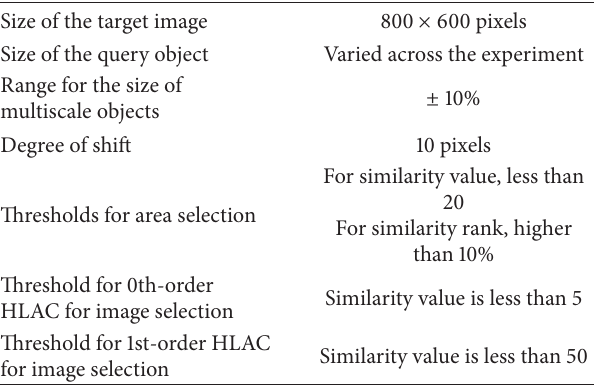
Table 1: Experimental